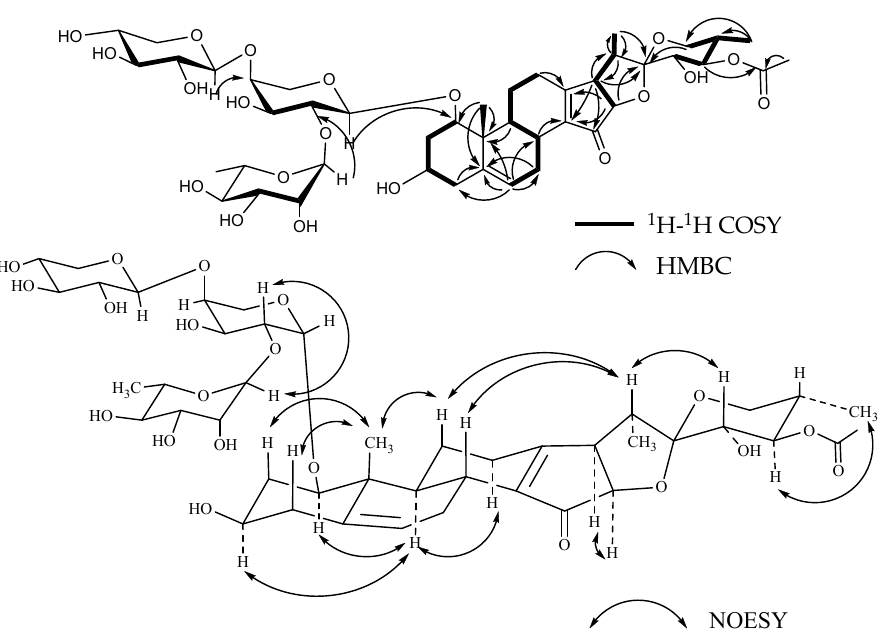
Figure 6. Key 1 H- 1 H COSY, HMBC, and NOESY correlations of compound 5 . The five known steroidal saponins, 6 – 10 , were defined as 25( R )-spirost-5-en-1 β ,3 β ,21,23 α ,24 β -pentol-1- O - β - D -apiofuranosyl-(1 → 3)- α -L-rhamnopyranosyl-(1 → 2)-[ β - D -xylopyranosyl-(1 → 4)]- a - L -arabinopyranoside ( 6 ) [21]; 15-oxo-18-nor-25( R )-spirost-5,13-diene-1 β ,3 β ,21,23 α ,24 β -pentol-1- O - β - D -apiofuranosyl-(1 → 3)- α - L -rhamnopyranosyl-(1 → 2)-[ β - D -xylopyranosyl-(1 → 3)]- a - L -arabinopyranoside( 7 )[24]; 15-oxo-18-nor-25( R )-spirost-5,13-diene-24-acetyl-1 β ,3 β ,23 α ,24 β -tetrol-1- O - β - D -apiofuranosyl-(1 → 3)- α - L -rhamnopyranosyl-(1 → 2)-[ β - D -xylopyranosyl-(1 → 3)]- a - L -arabinopyranoside ( 8 ) [25]; 15-oxo-18-nor-25( R )-spirost-5,13-diene-1 β ,3 β ,21,23 α ,24 β -pentol-1- O - β - D -apiofuranosyl-(1 → 3)- α - L -rhamnopyranosyl-(1 → 2)-[ β - D -xylopyranosyl-(1 → 4)]- a - L -arabinopyranoside ( 9 ) [26]; 25( R )-spirost-5-en-1 β ,3 β ,21,23 α ,24 β -pentol-1- O - β - D - α - L -rhamnopyranosyl-(1 → 2)-[ β - D -xylopyranosyl-(1 → 3)]- a - L -arabinopyranoside ( 10 ) [27] (Tables 5 and 6) by comparison of the physical and spectroscopic data available in the literature. Table 5. 13 C-NMR data of the aglycone moieties of compounds 6 – 10 .